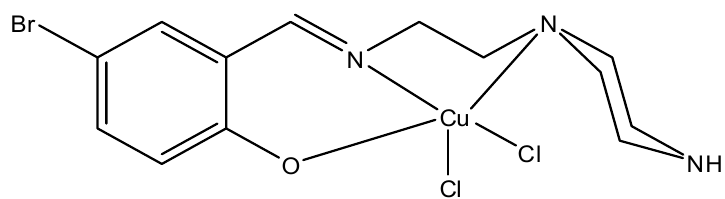
Figure 1. Molecular structures of CuLBS complex.